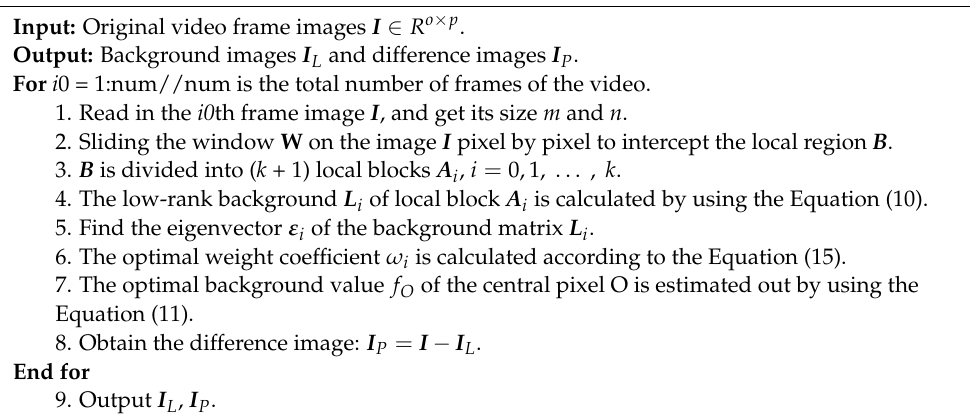
Algorithm 1 The pseudo code of SPB